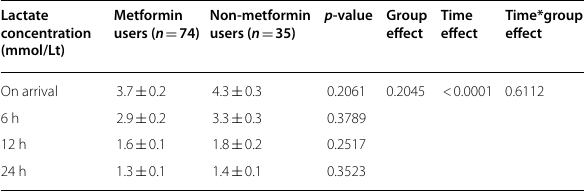
Table 2. Lactate clearance comparison of metformin users vs other antiglycemic medication Lactate